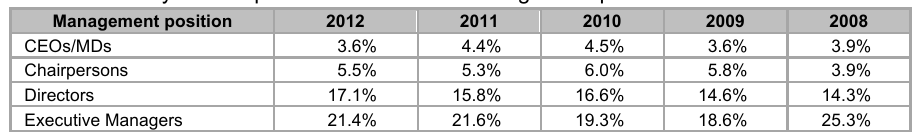
Year-to-year comparison of women in management positions in South Africa Management